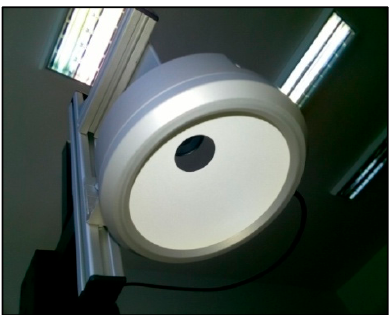
Figure 10. Configuration of the camera and lighting.